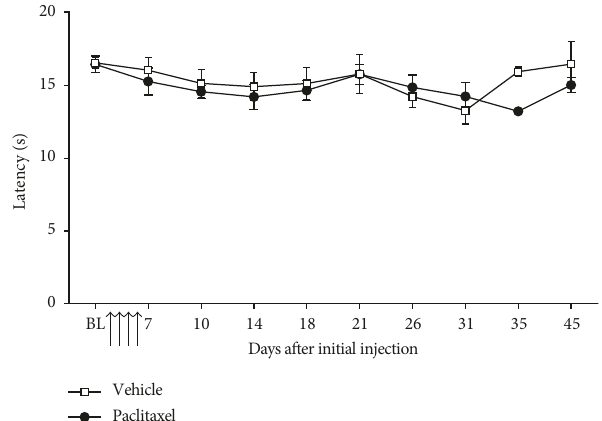
Figure 4: Effect of paclitaxel administration on heat hypersensi- tivity. Graph shows the mean SEM of the hind paw withdrawal latency to a radiant heat stimulus. BL baseline before paclitax- (cid:31) el/vehicle administration. Arrows indicate four injections of ± 2 mg/kg paclitaxel or equivalent volume of vehicle on days 0, 2, 4, and 6 ( n 6 per (cid:31)